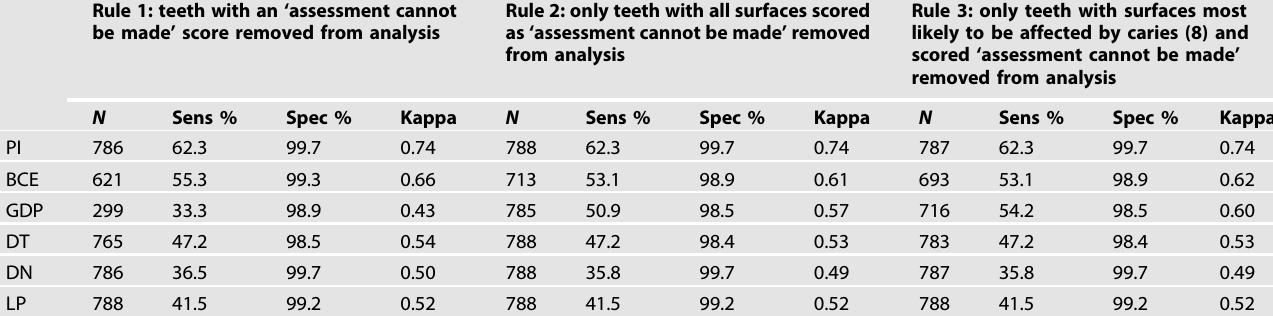
Table 1. Sensitivity, speci fi city and kappa scores for each rule to compare photographic assessments to the gold standard. Rule 1: teeth with an ‘ assessment cannot be made ’ score removed from analysis